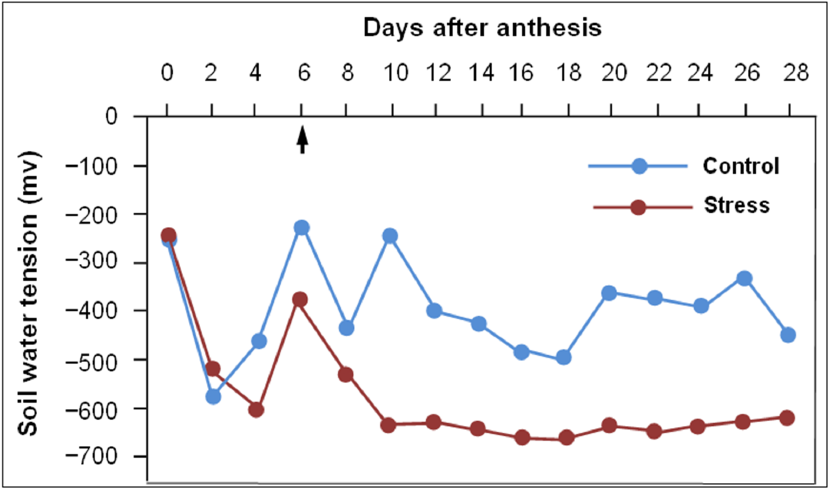
Figure 1. Soil-water tension (mv) of pot soils in control and drought treatments. Arrow indicates the sudden spell of light rain which contributed to the rise in soil water tension both in control and drought.